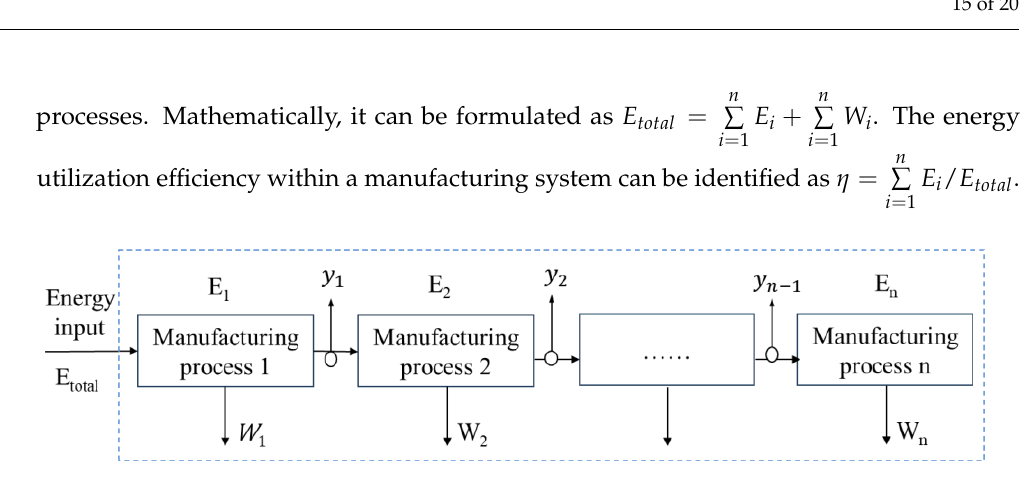
Figure 9. A single energy flow diagram in a multi-stage manufacturing system.